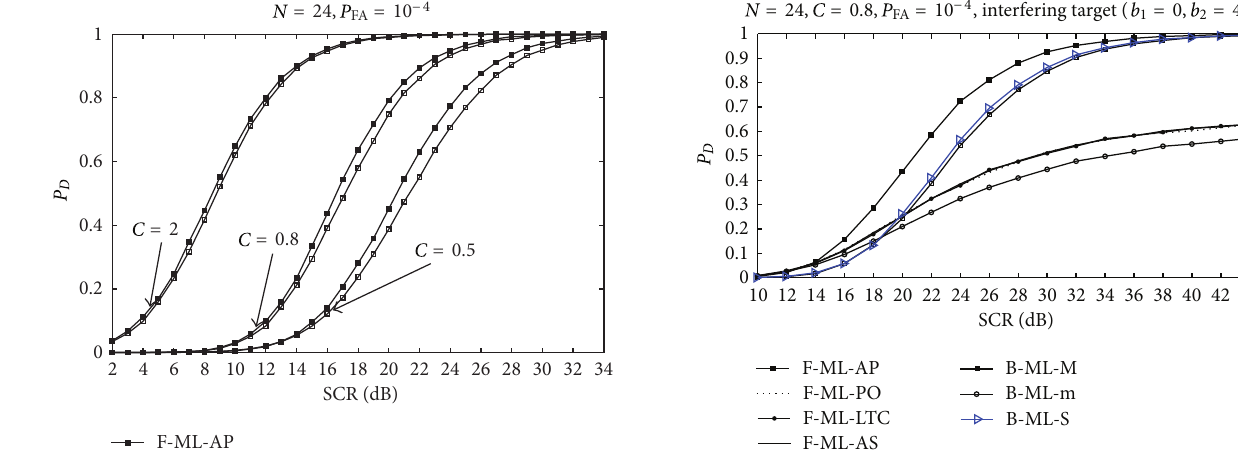
F 5: Performance comparison between distributed detector based on ML and OS CFAR algorithms in local sensors for different values of the shape parameters.